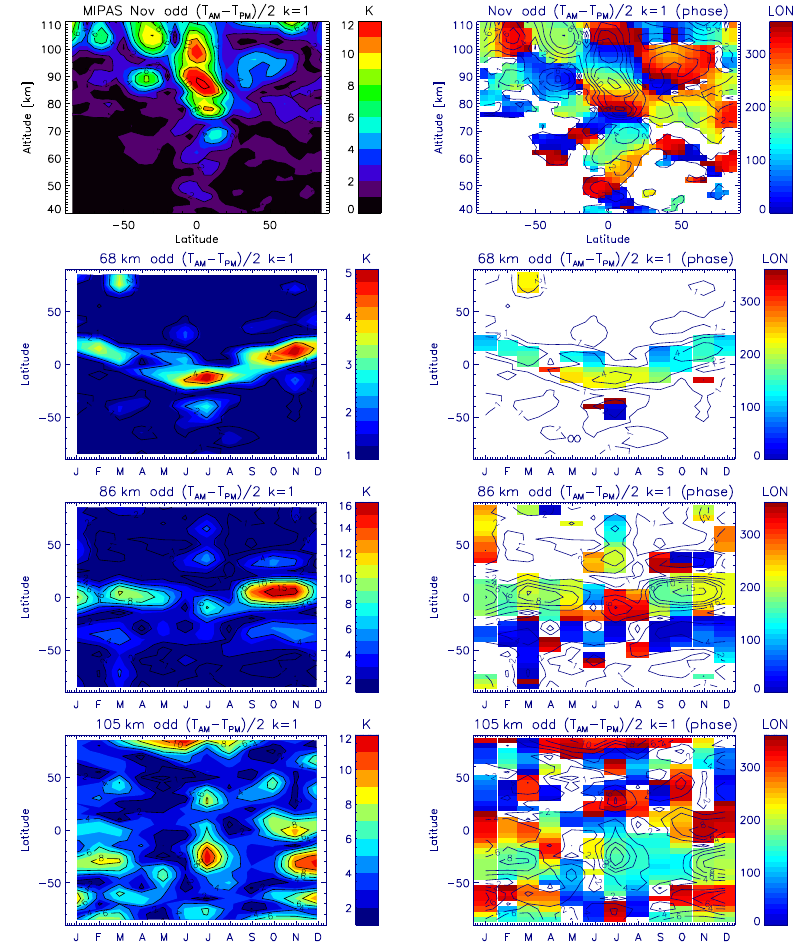
Figure 6. Latitude–altitude fields for November (first row) and latitude–time fields at 68, 86 and 105km (second–fourth rows) of amplitudes and phases of MIPAS average (2007–2012) | n odd − s | = 1 mode. D0, DW2 and TW2 tidal oscillations are